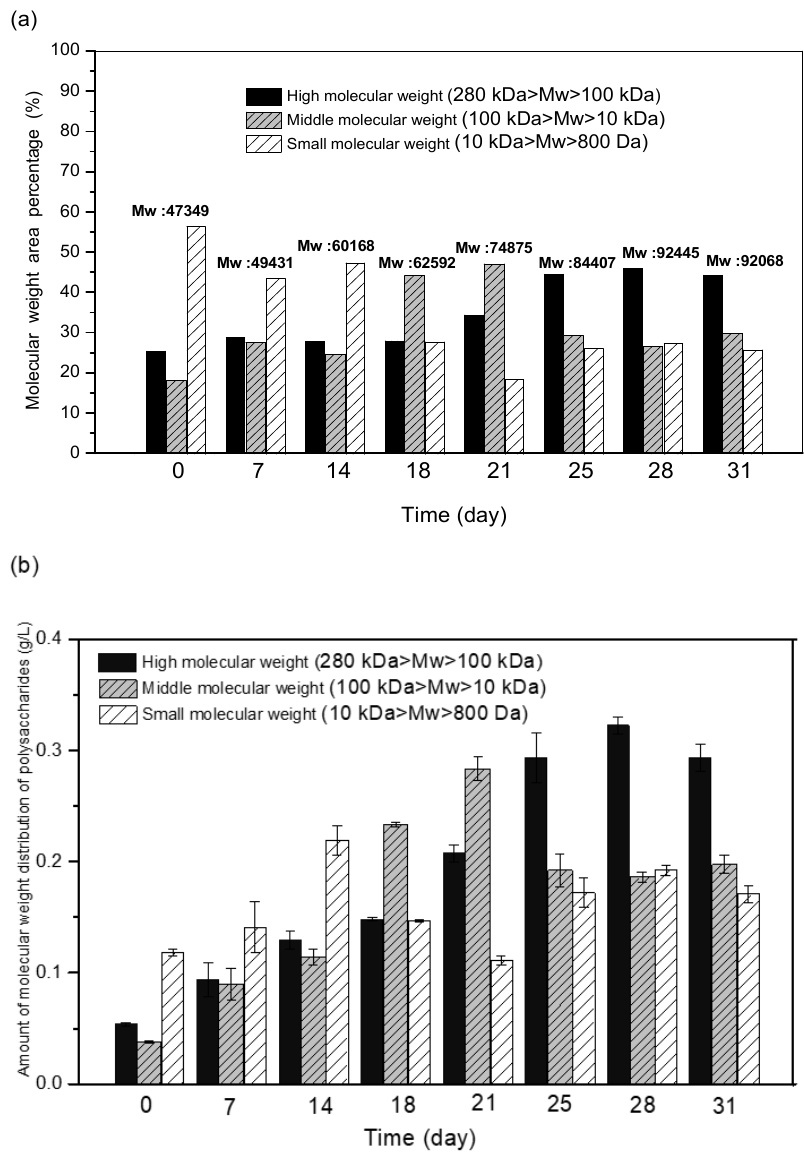
Figure 7. ( a ) Average molecular weight of EPS produced; ( b ) Molecular weight distribution of EPS produced during different days of submerged fermentation.